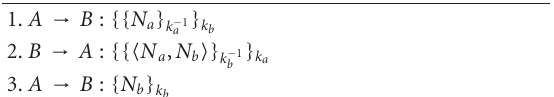
Table 13: Needham schroeder lowe protocol: corrected version.